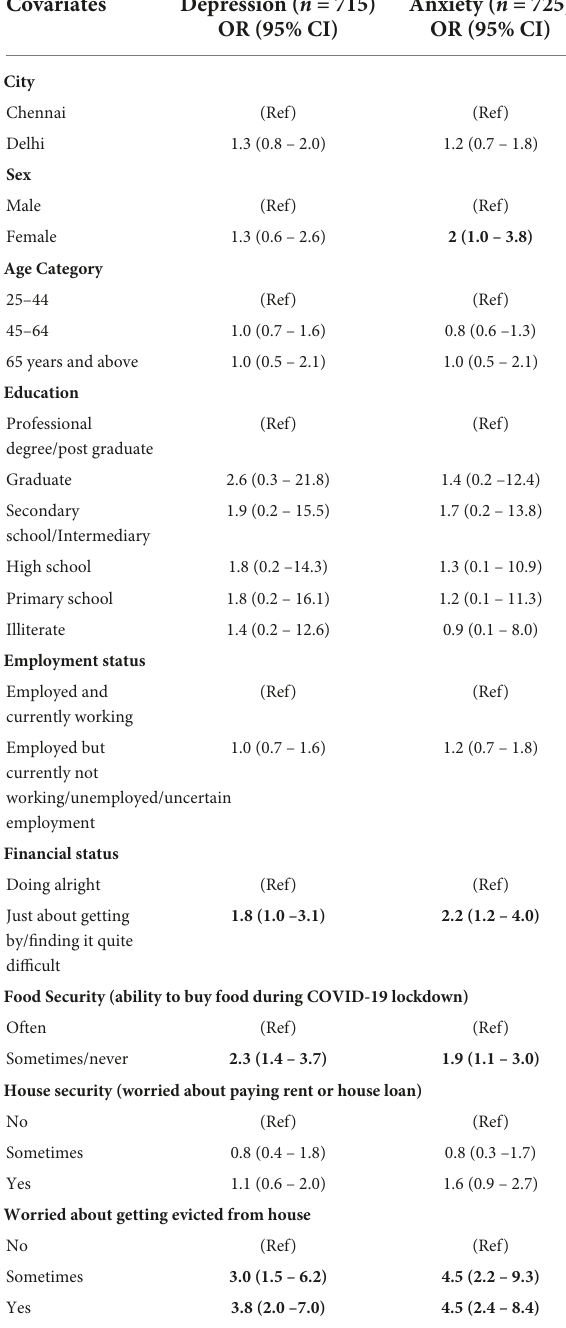
TABLE 3 Predictors of depression and anxiety in adult tobacco users during